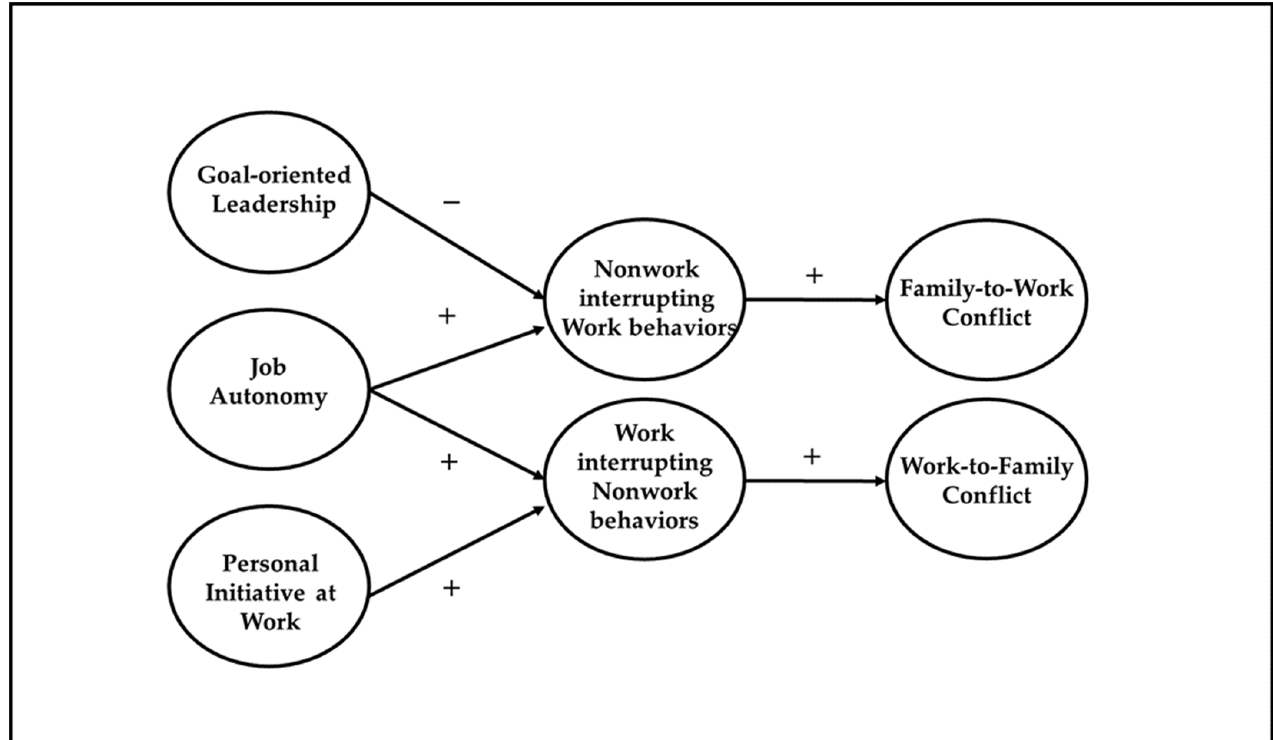
Figure 1. The overarching conceptual model. Note. Solid lines are used to represent hypothesized direct effects.